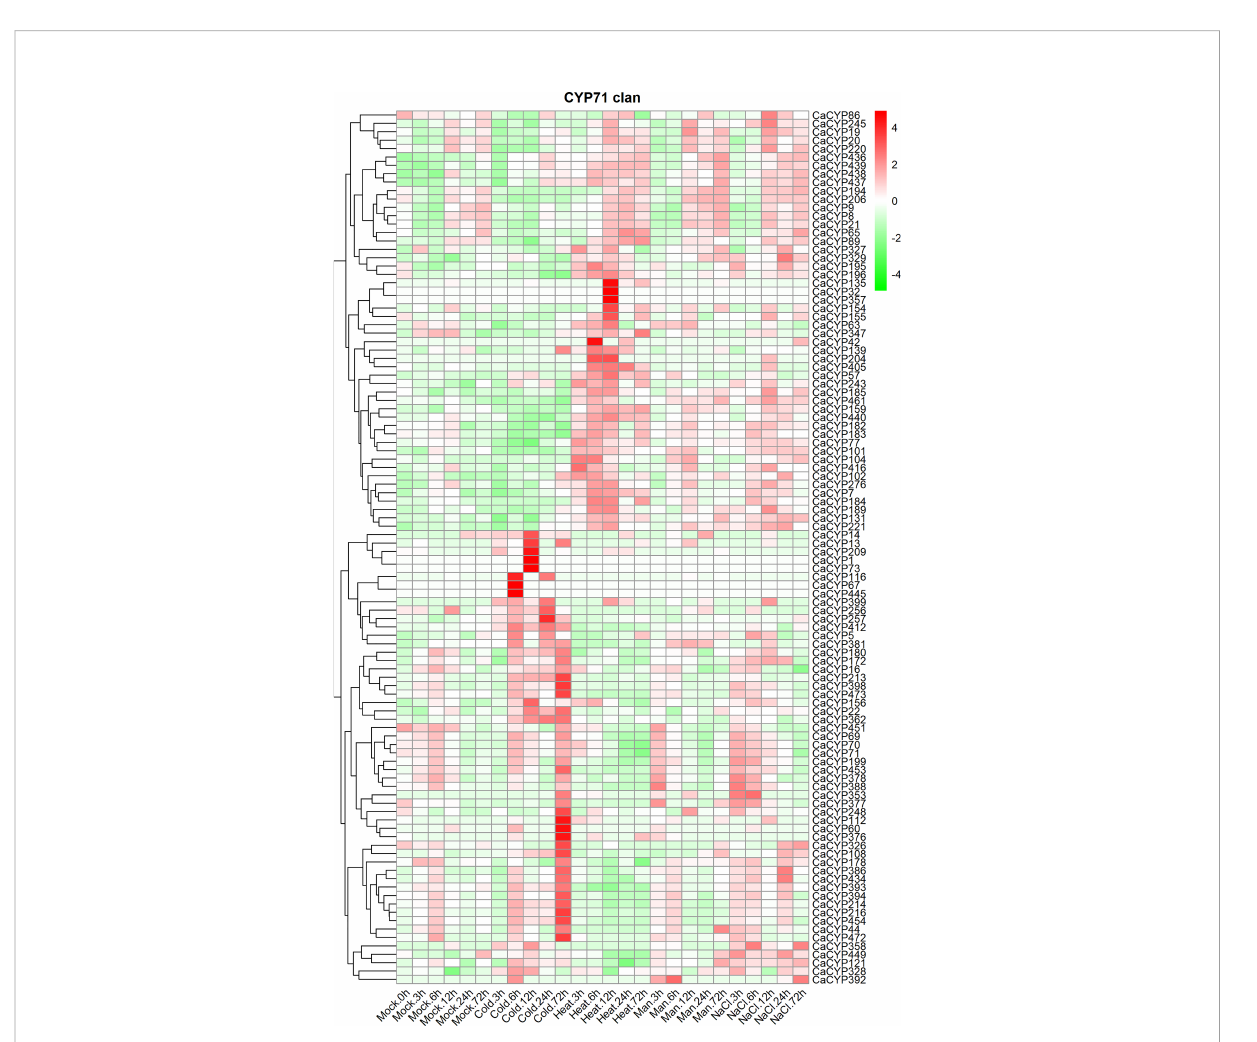
FIGURE 6 Analysis of the expression patterns of the selected CaCYP genes in different abiotic stresses. Heatmaps of normalized RNA-seq data prepared from three biological replicates. The high-expression level is marked by red color, and the low-expression level is marked by green color. Expression levels under abiotic treatment, including cold, heat, drought (Man), and salt (NaCl). Different time points include 3, 6, 12, 24, and 72 h. The control group is represented by the Mock